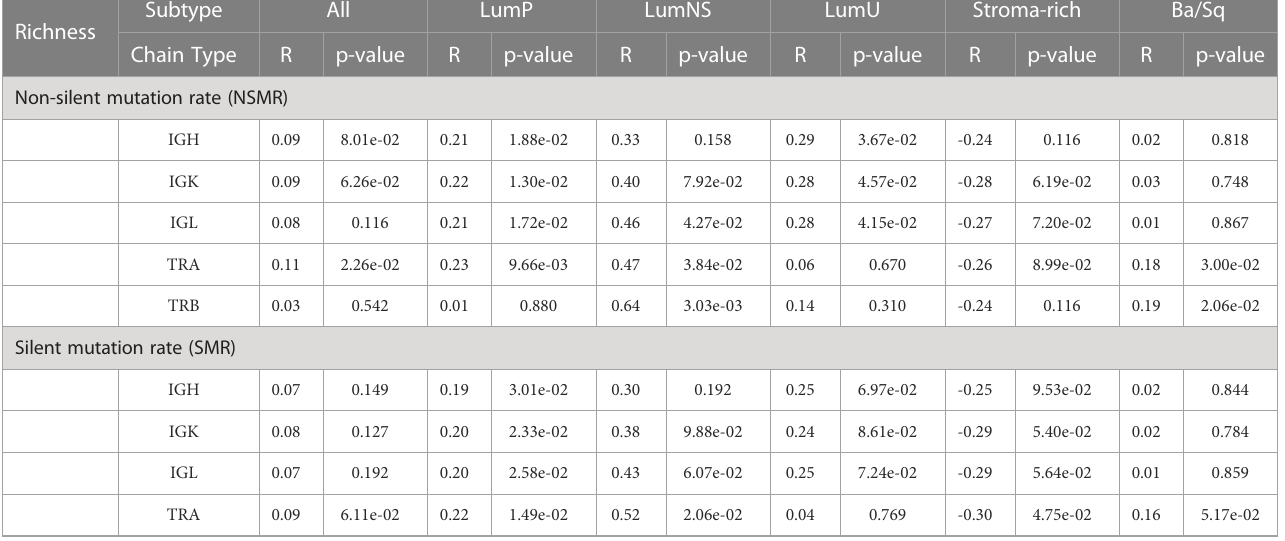
TABLE 2 Correlation between the two mutational rates and in fl ammatory score and richness for all receptors by subtypes.